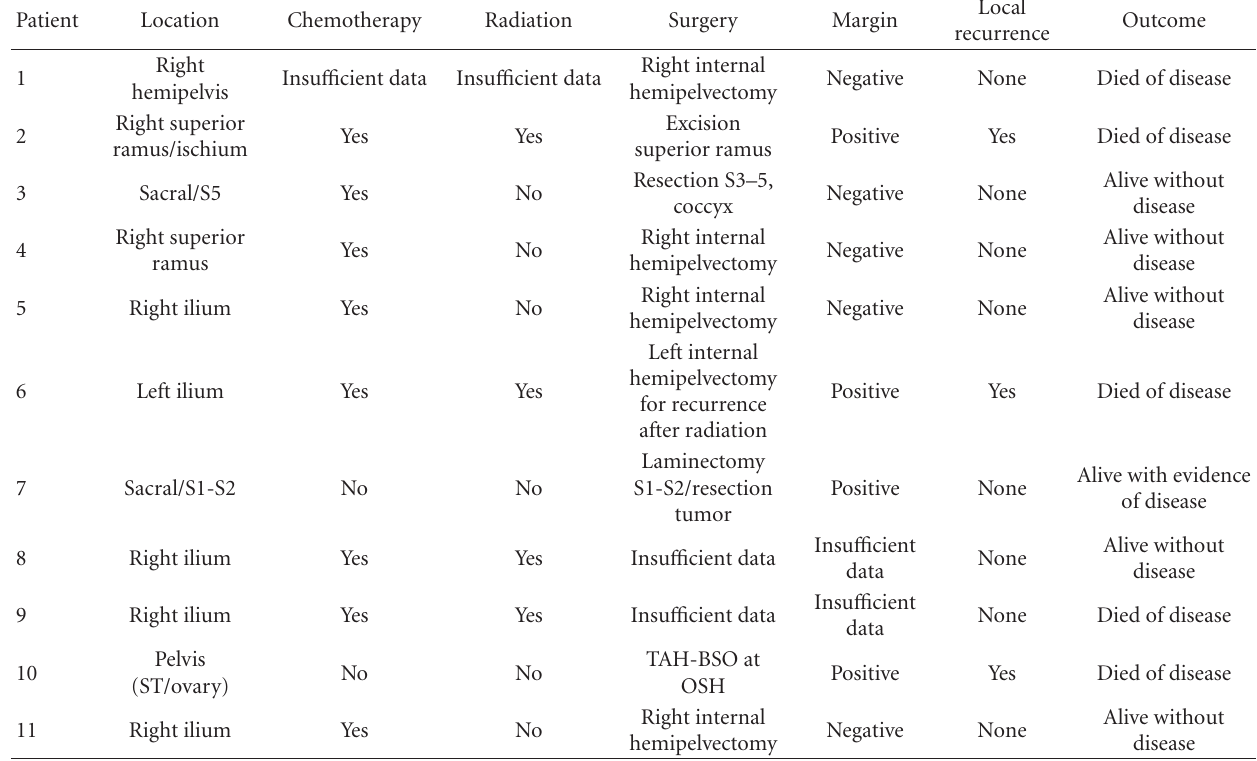
Table 3: Data for patients with pelvic location